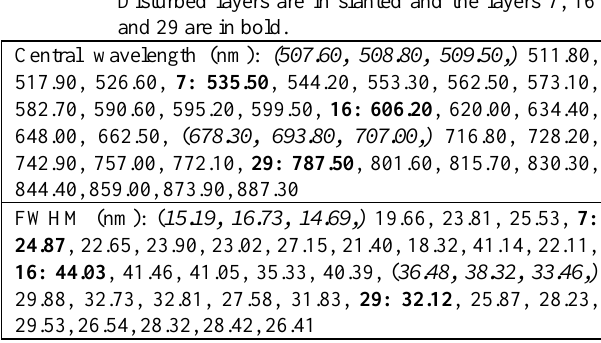
Figure 3. The optical construction of the sensor module. An opal glass diffuser was used in the module to increase the acceptance angle of the sensor.